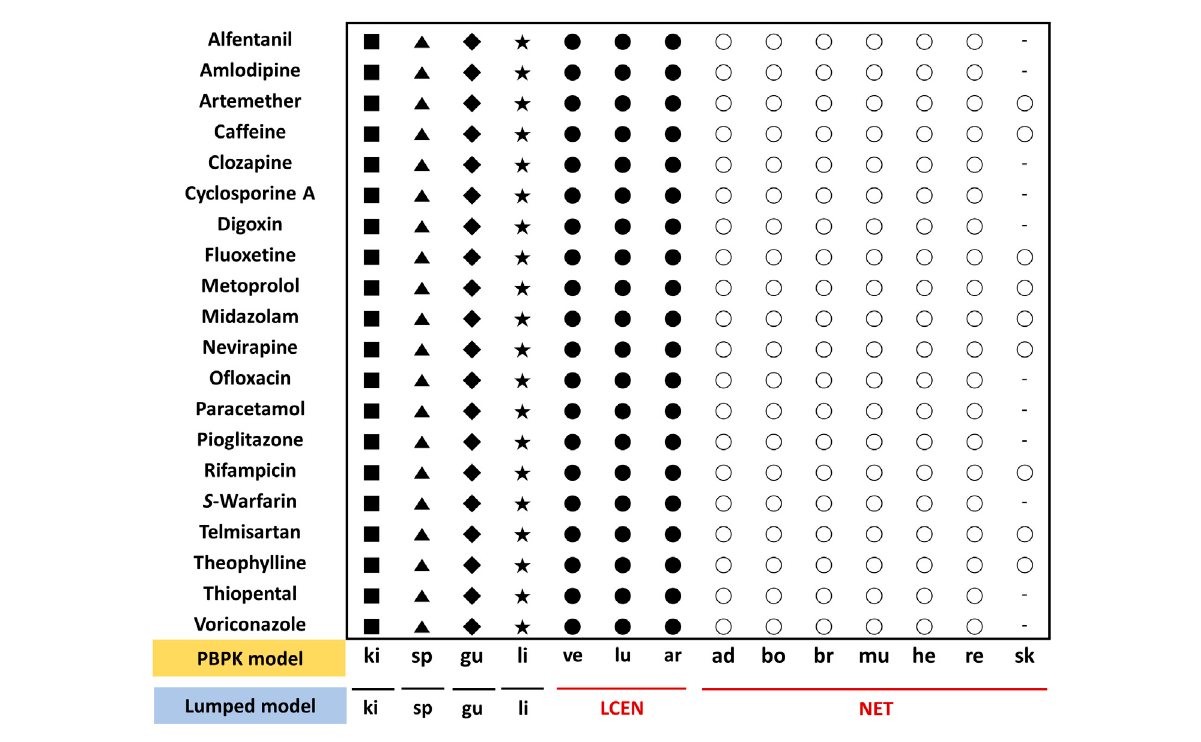
FIGURE 2 Assignment of tissues of the PBPK model to the lumped compartments of the lumped model for 20 model compounds. The lumped central compartment(LCEN)isrepresentedbyblackcirclesandthenon-eliminatingtissuescompartment(NET)isrepresentedbywhitecircles.Thenumber ofdifferentsymbolsforagivencompoundcorrespondstothenumberofcompartmentsinthelumpingmodel.Abbreviationsad,adipose;ar,arterial blood; bo, bone; br, brain; gu, gut; he, heart; ki, kidney; li, liver; lu, lung; mu, muscle; re, rest of body; sk, skin; sp, spleen; ve, venous